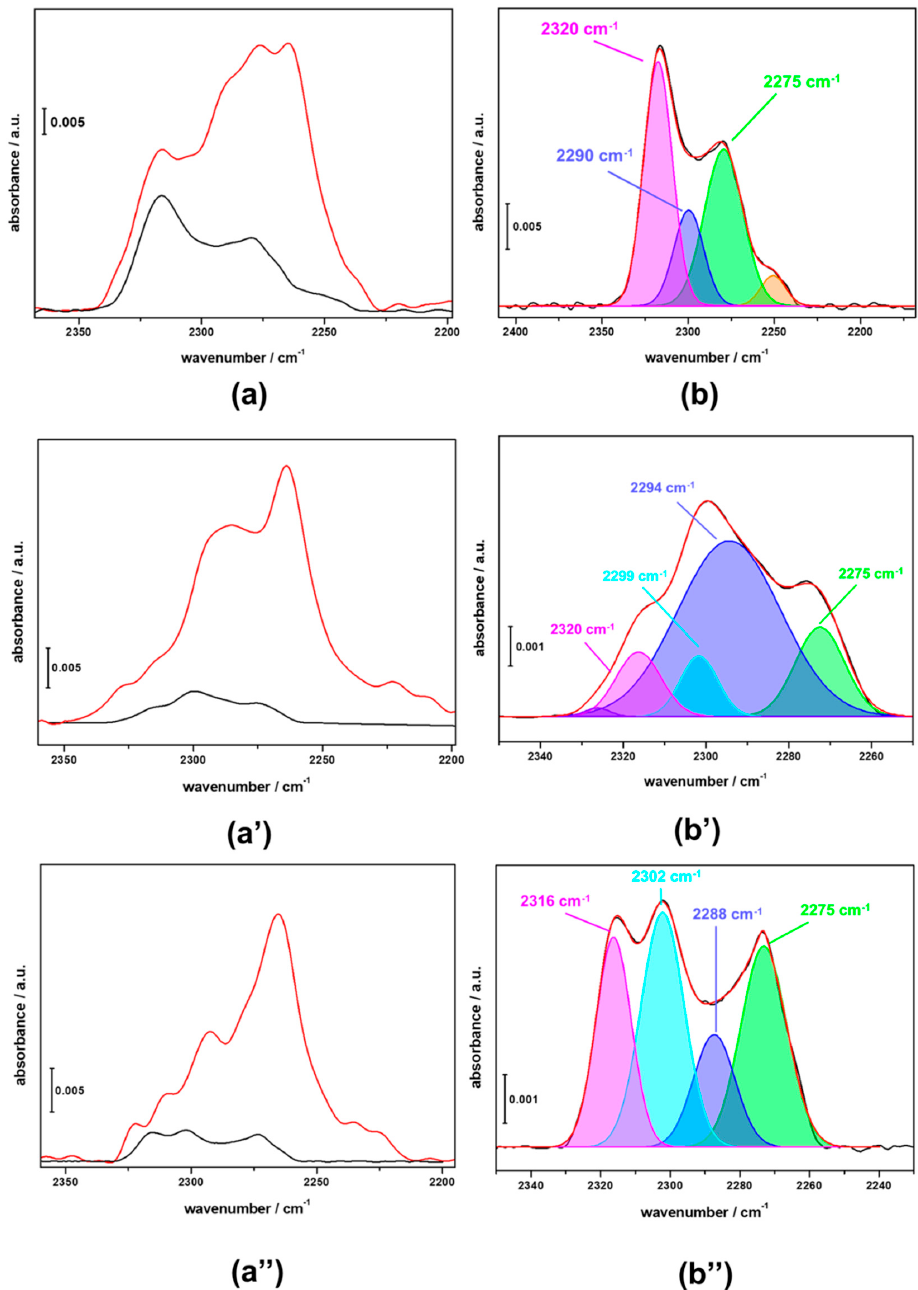
Figure 3. FTIR difference spectra of CZZFER catalysts at maximum d 3 -acetonitrile coverage and after desorption of the probe molecules at r.t. (red and black curves, respectively, in sections a , a’ , a” ). In sections b , b’ and b” the deconvolution of the irreversible fraction at r.t. is reported. (Sections a and b refer to CZZFER8; sections a’ and b’ refer to CZZFER30; sections a” and b” refer to CZZFER60.)